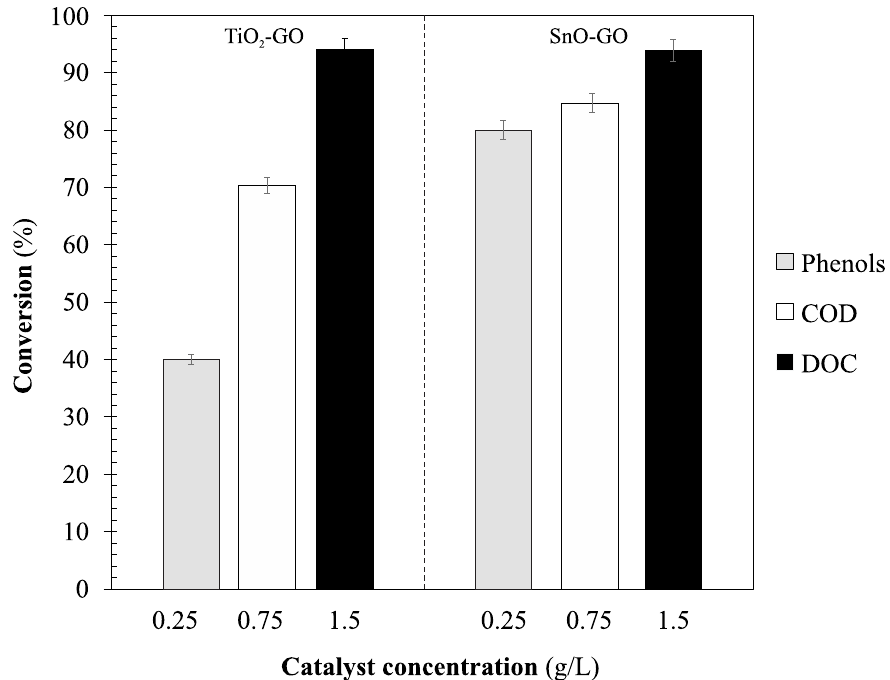
Figure 9. Removal e ffi ciencies obtained in the photocatalytic process with SnO-GO and TiO 2 -GO. Figure 9. Removal efficiencies obtained in the photocatalytic process with SnO-GO and TiO 2 -GO.